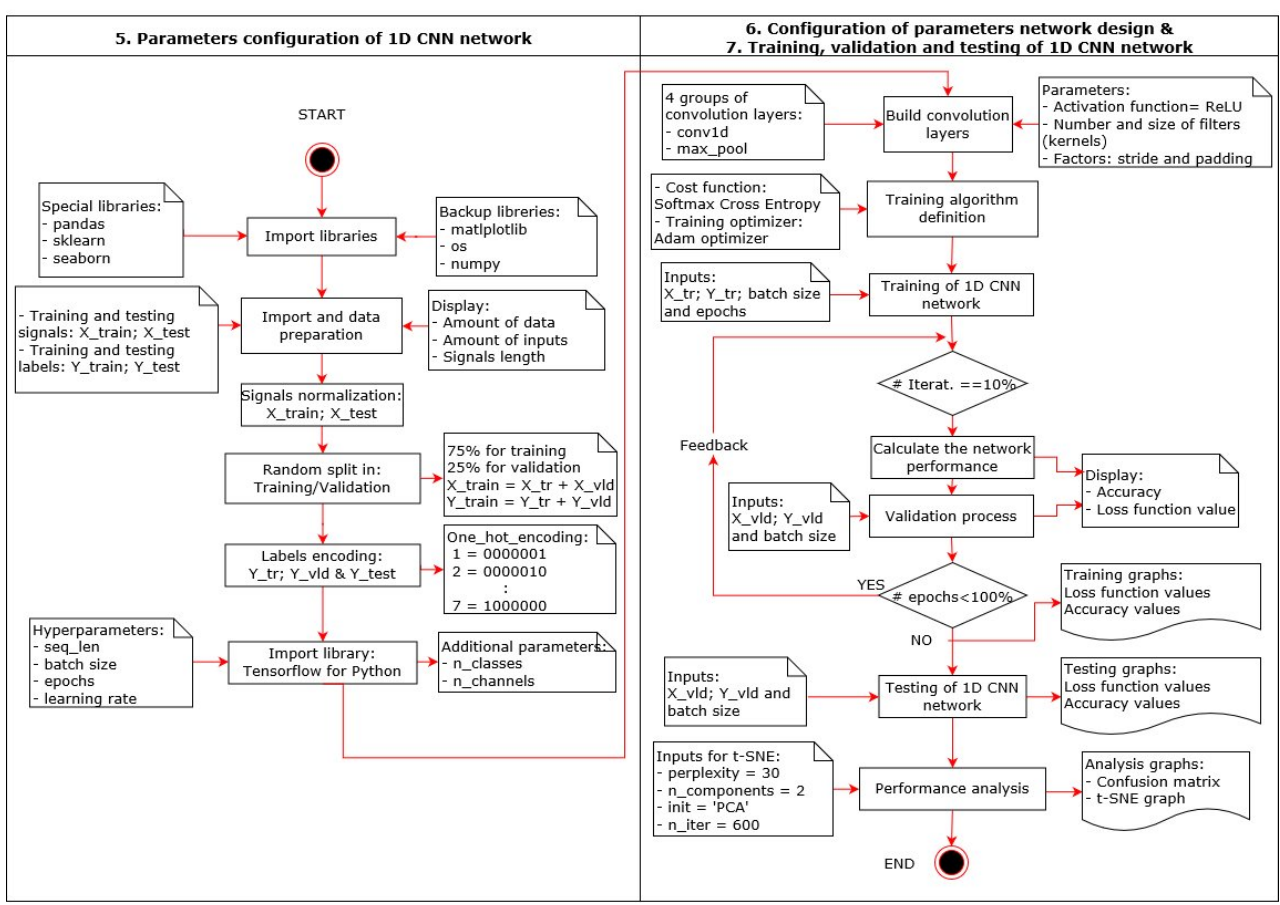
Figure 5. 1D-CNN network algorithm.